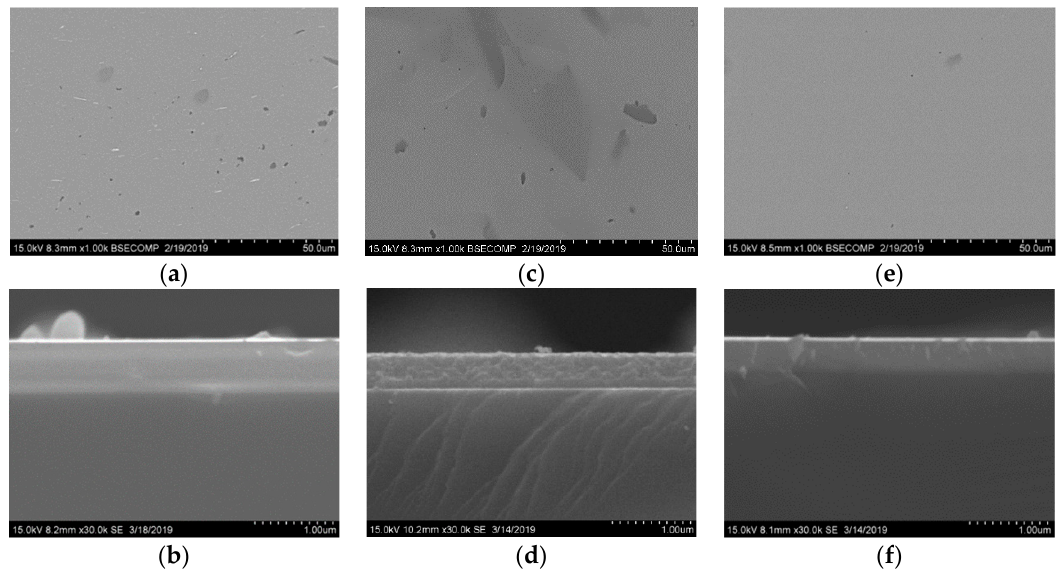
Figure 2. Typical plane-view and cross-sectional scanning electron microscopy (SEM) images of coatings 1 ( a , b ), 2 ( c , d ), and 3 ( e , f ) deposited onto the silicon.